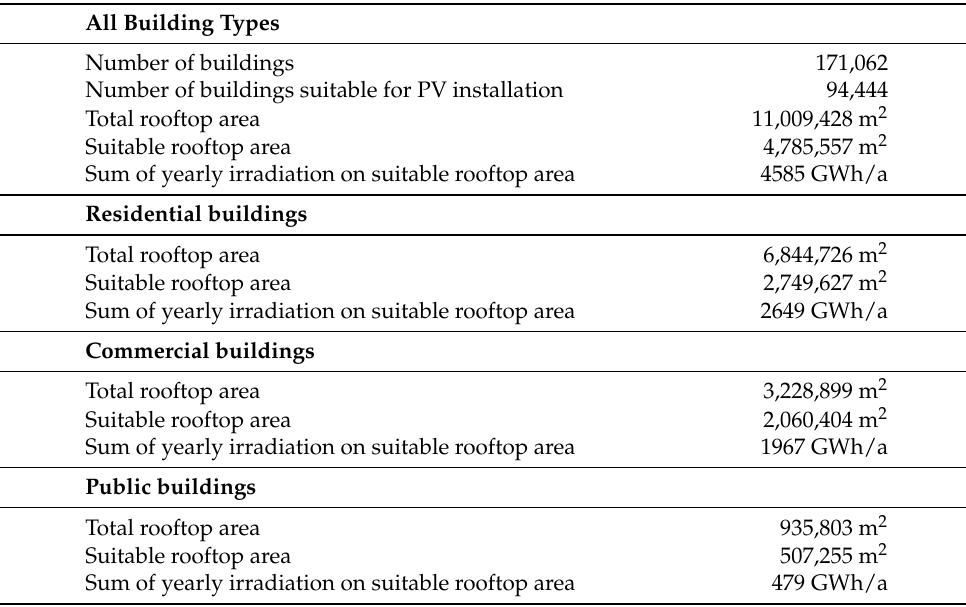
Table 2. Results of the PV potential analysis carried out in and around the city of